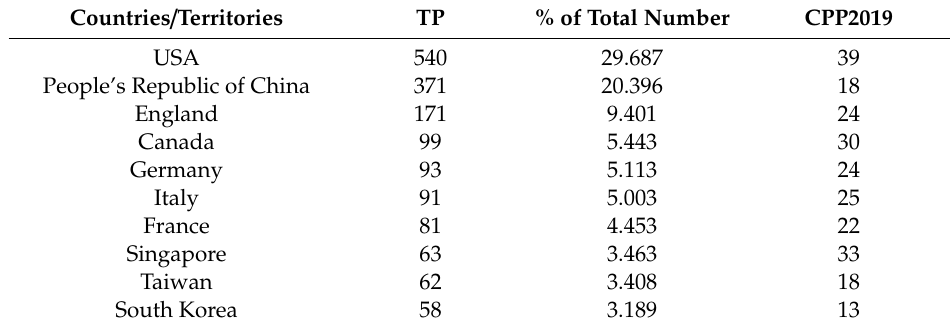
Figure 6. Co-Authorship of Mass Customization researchers at the country level (1990–2020). Source: Composed by the authors using VosViewer software. Table 3. The top 10 productive countries regarding the Mass Customization research domain in 1990–